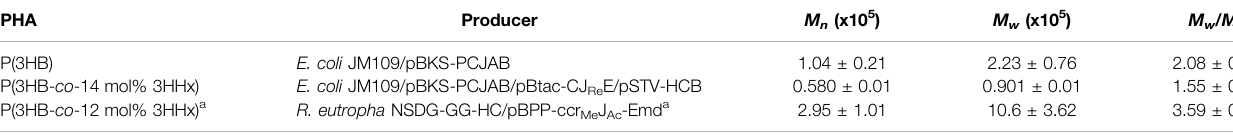
TABLE 1 | Molecular weights of P(3HB- co -3HHx) synthesized by recombinant strains of E. coli and R. eutropha from glucose. PHA